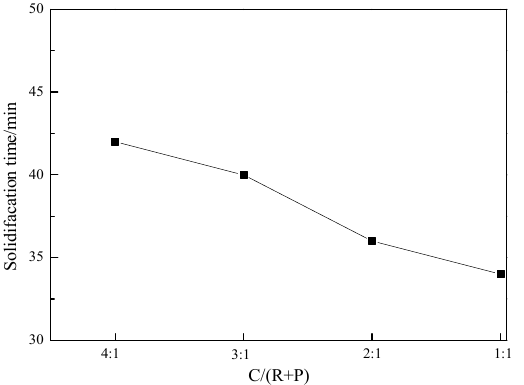
Figure 6. Solidification times with different ratios of cement, red mud and